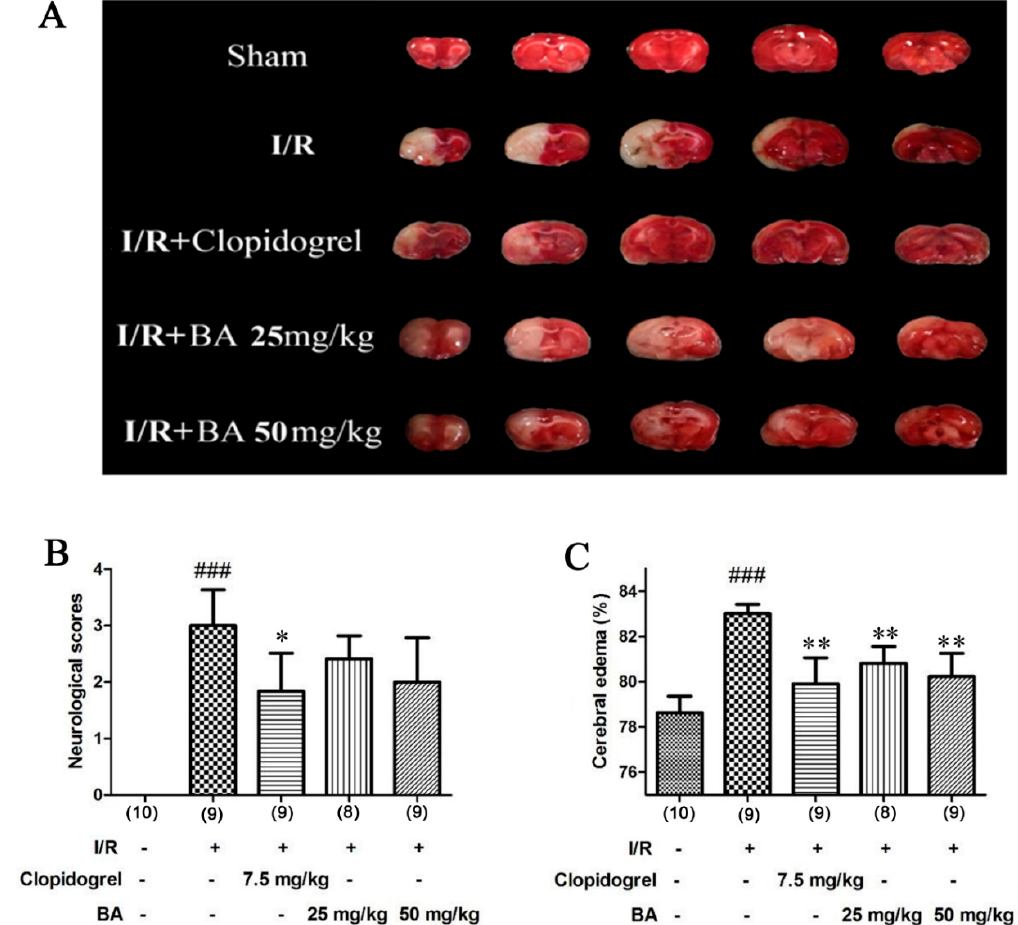
Figure 2. The protection of BA against cerebral infarction ( A ), neurological score ( B ), and edema ( C ) ( C ) compared with sham rats (### p < 0.001) and compared with I / R group (* p < 0.05 and ** p < 0.01). compared with sham rats (### p < 0.001) and compared with I/R group (* p < 0.05 and ** p < 0.01). The The Arabic number in brackets represent the numbers of animals in each Arabic number in brackets represent the numbers of animals in each group.